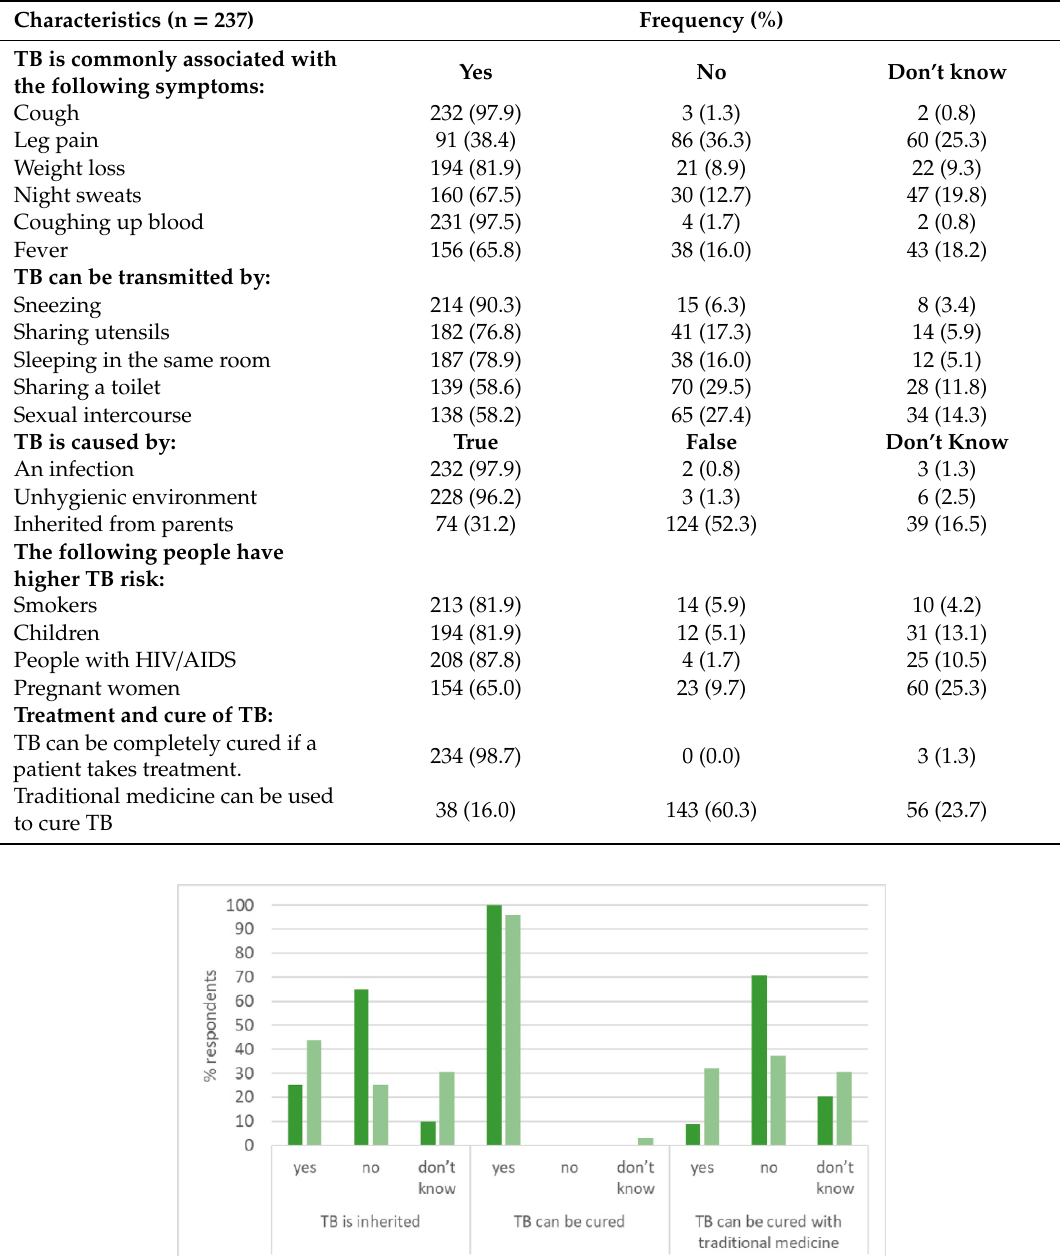
Table 2. Knowledge among contacts of tuberculosis patients.